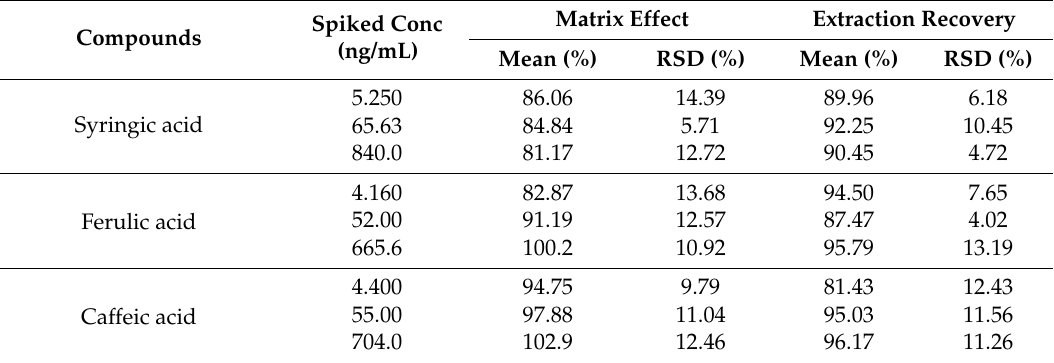
Table 2. Matrix effect and extraction recovery for the seven analytes and IS ( n = 6). Spiked Conc Compounds